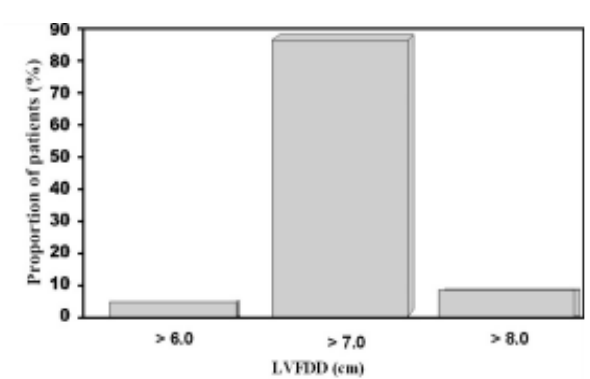
Fig. 2 - Accumulated distribution of FSDLV among 465 patients submitted to partial left